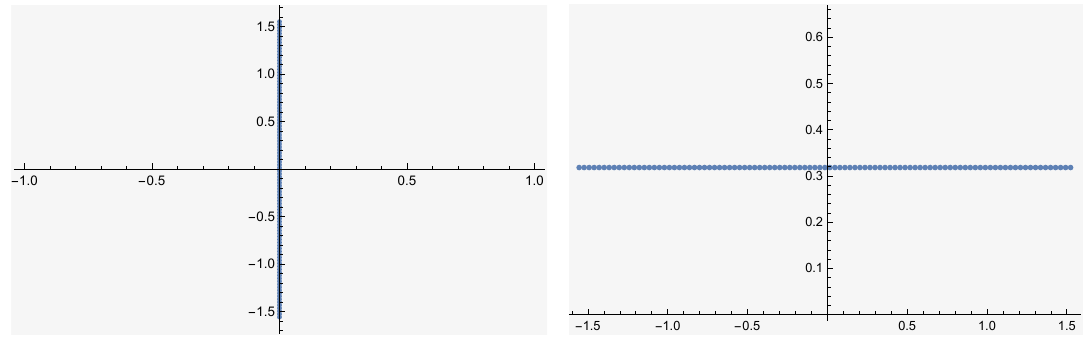
Figure 2 . The left figure shows the numerical solution which corresponds to the confinement phase plotted on the Complex plane with the parameters ( N, N f , m ) = (100 , 3 , 8). The solution actually lies on the Imaginary axis. The right one shows the density function of it. We can check that the solution does not depend on the parameters.